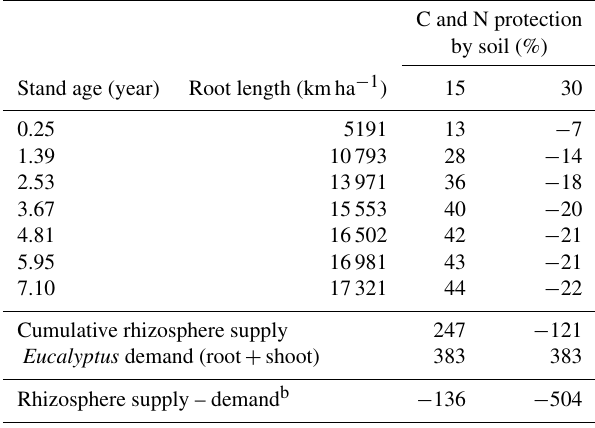
Table 3. Simulation of N balance (kgNha − 1 ) due to the priming effect in Eucalyptus plantations with two levels of soil protection (Kpr of 15 or 30) of C and N.